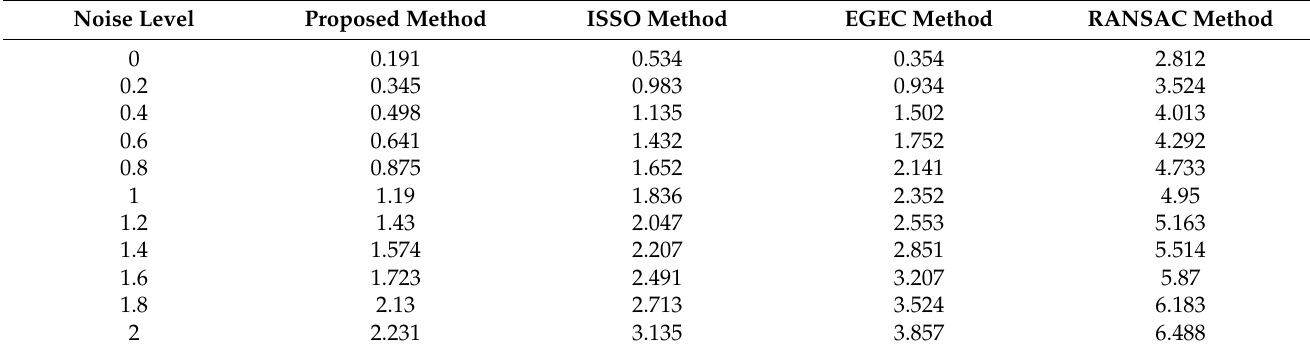
Table 2. The mean distance between feature point and intersection point of synthetic data